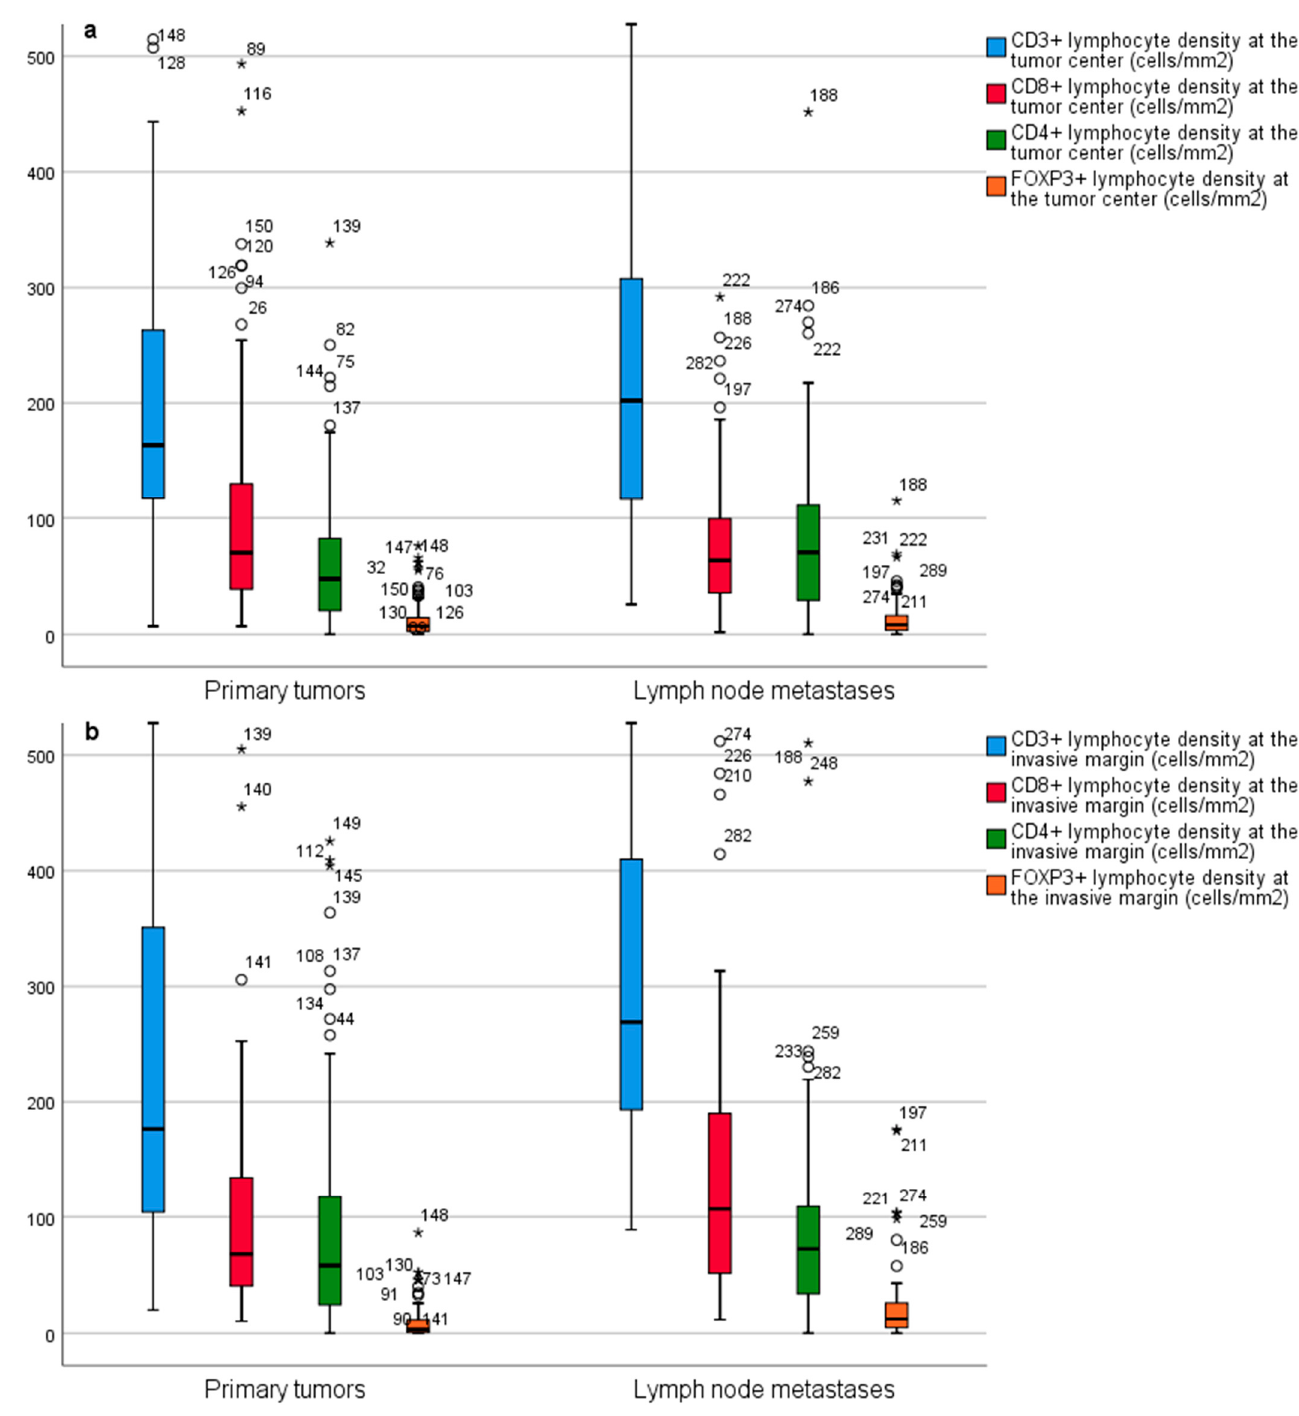
Figure 5. ( a ) Comparison of CD3 + , CD8 + , CD4 + and FOXP3 + immune cell densities between primary small bowel neuroendocrine tumors and small bowel neuroendocrine tumor lymph node metastases at the tumor center and ( b ) at the invasive margin. Outliers are marked with asterisks (*).